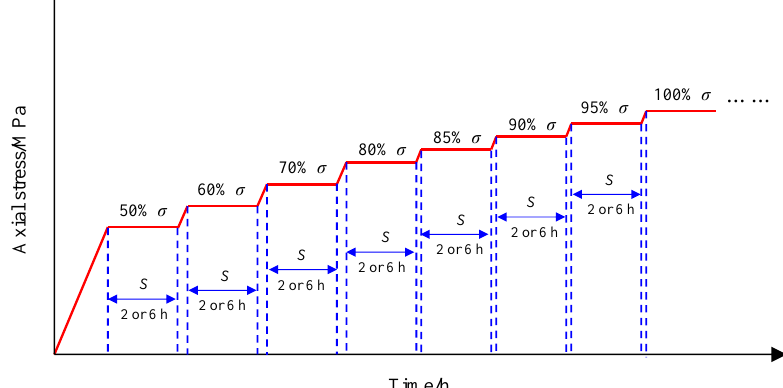
Figure 5. Creep test scheme for sandstone-coal composite samples.